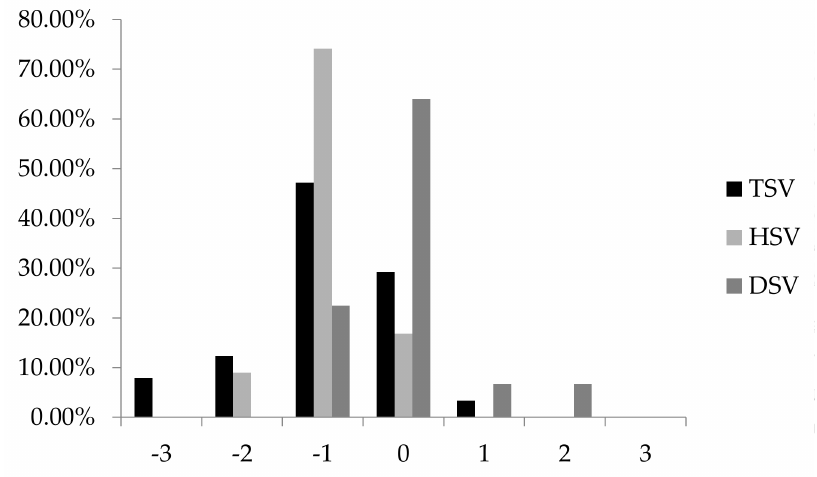
Figure 11. TSV, HSV, DSV in winter.